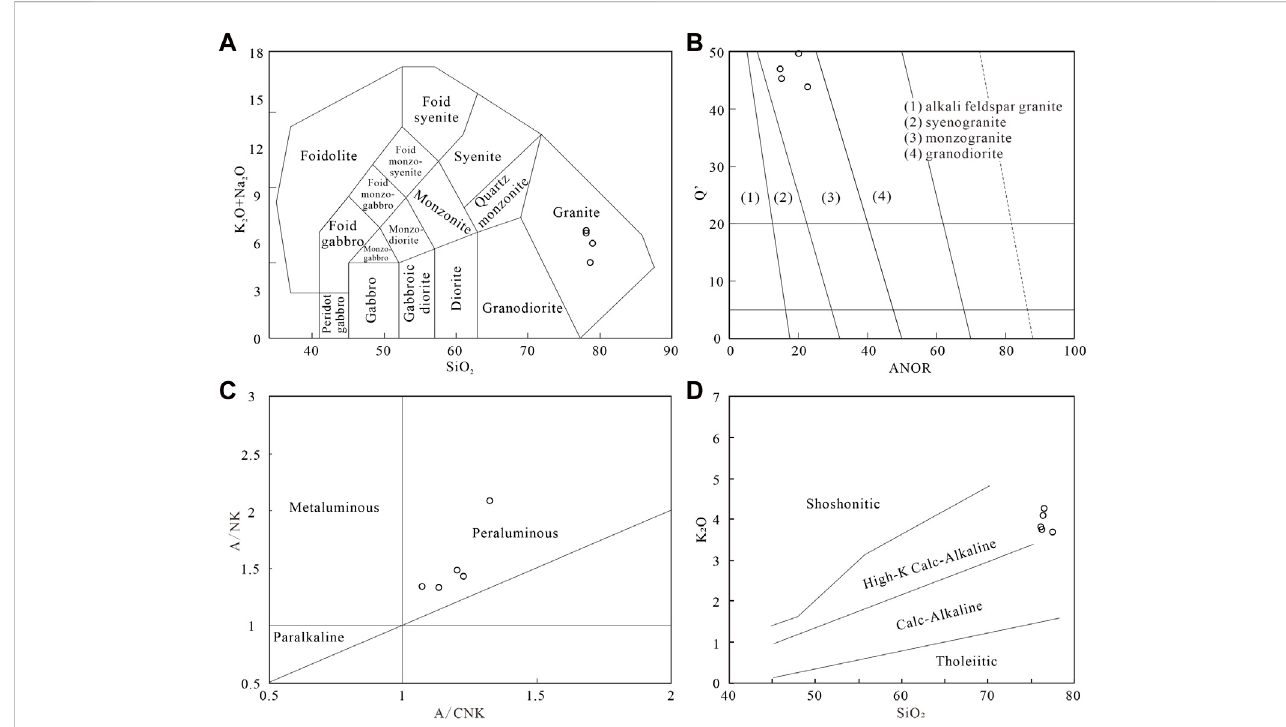
FIGURE 6 TASdiagram[ (A) ;Middlemost,1994],Q ′ versusANORdiagram[ (B) ;StreckeisenandLeMaitre,1979],A/NKversusA/CNKdiagram[ (C) ;ManiarandPiccoli, 1989], and K 2 O versus SiO 2 diagram [ (D) ; Peccerillo and Taylor, 1976] for